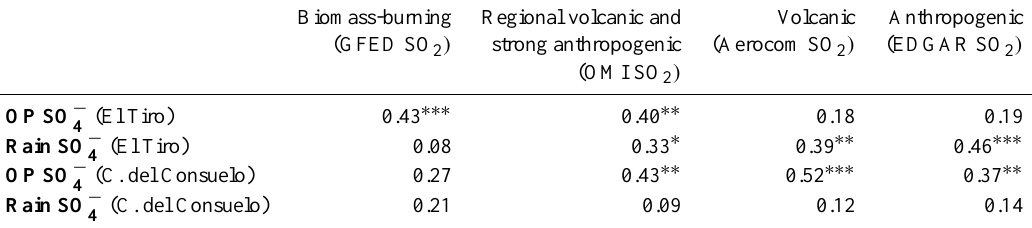
Table 3. Cross-correlation matrix for SO 2 transport concentrations above El Tiro and Cerro del Consuelo pixels and sulfate concentrations from meteorological stations (MSs) at these two sites, located on an upriver mountain pass and on the highest catchment peak, respectively. ) concentrations and non-bold variables SO 2 transport. The acronym OP stands for occult Variables in bold represent measured sulfate (SO − 4